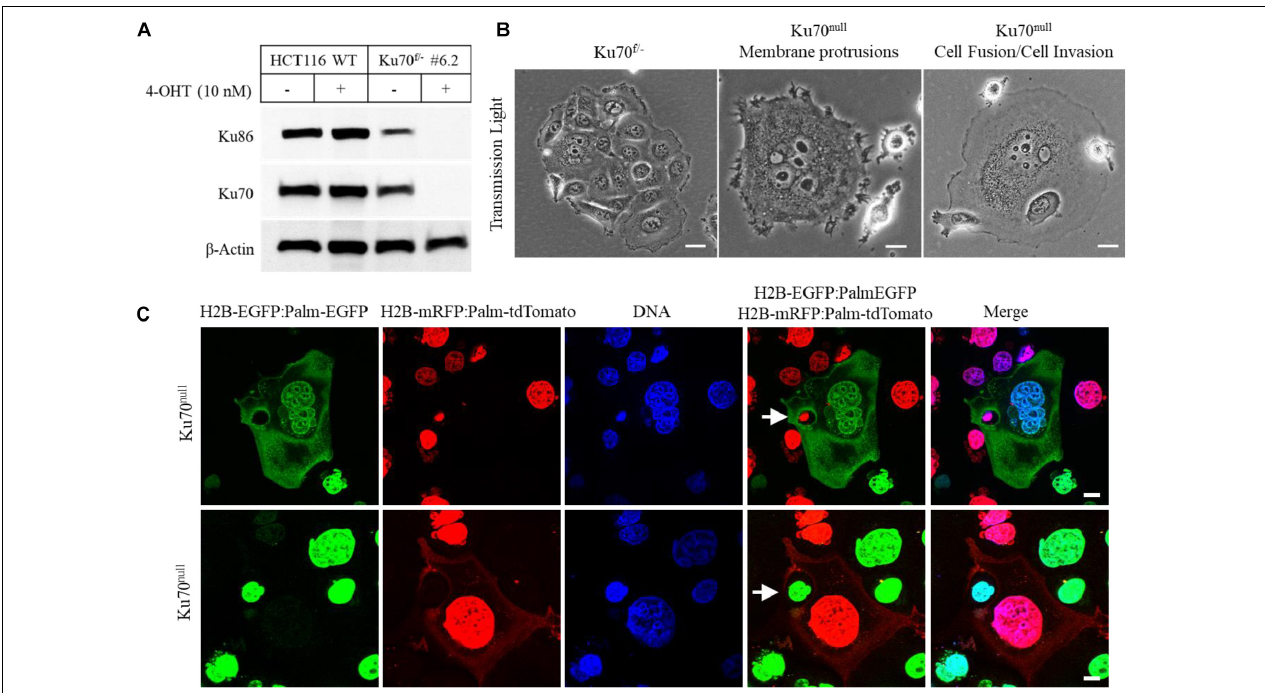
FIGURE 1 | Conditional loss of Ku70 in HCT116 cells leads to cell invasion. Ku70 and Ku86 were detected in the cell extracts of wild-type (WT) and engineered HCT116 cells (Ku70 f / - cells; clone no. #6.2) following the treatment with 10 nM 4-OHT for 10 days to obtain conditionally-null Ku70 (Ku70 null ) cells (A) . Phase contrast images of HCT116 Ku70 f / - and Ku70 null cells showing formation of giant cells, elongated membrane protrusions, cell fusions, cell invasion, and cell-in-cell structures at Day10 of 4-OHT treatment. Scale bar, 20 µ m (B) . Confocal microscopy examination of Ku70 null cells following live-cell imaging. HCT116 Ku70 f / - cells expressing H2B-EGFP:Palm-EGFP or H2B-mRFP:Palm-tdTomato were treated with 10 nM 4-OHT for 5 days and co-cultured at 1:1 ratio 1 day prior to the imaging. Following the live-cell imaging for 48 h, cells were fixed and examined via a confocal microscope. Two different examples of giant host cells with engulfed nuclei/cell (white arrows) are shown. Scale bar, 10 µ m (C)